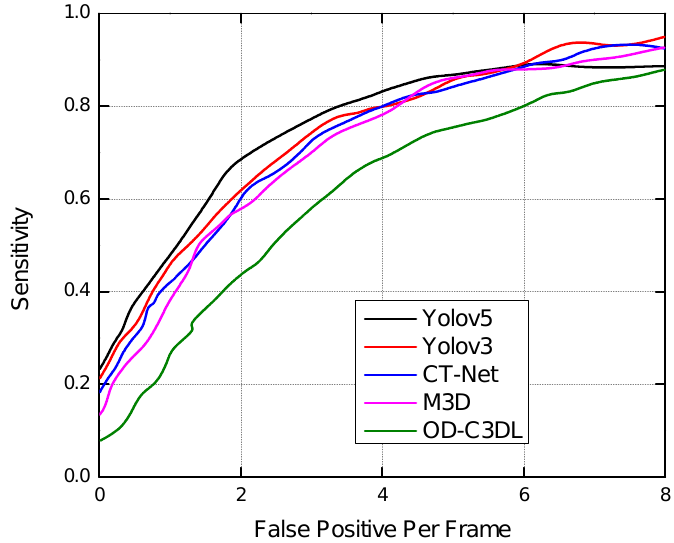
Figure 9. Sensitivity vs. False Positive Per Frame for multiple models.